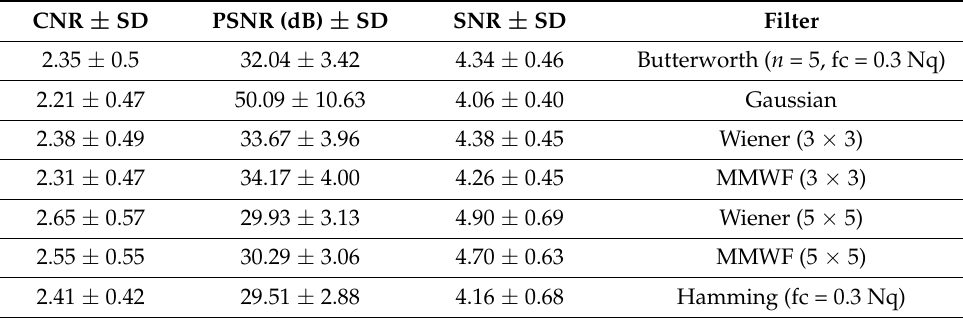
Table 3. Average ( ± standard deviation (SD)) indices of signal-to-noise (SNR), peak signal-to-noise (PSNR), and contrast-to-noise (CNR) of different filters for the studied myocardial perfusion SPECT images.